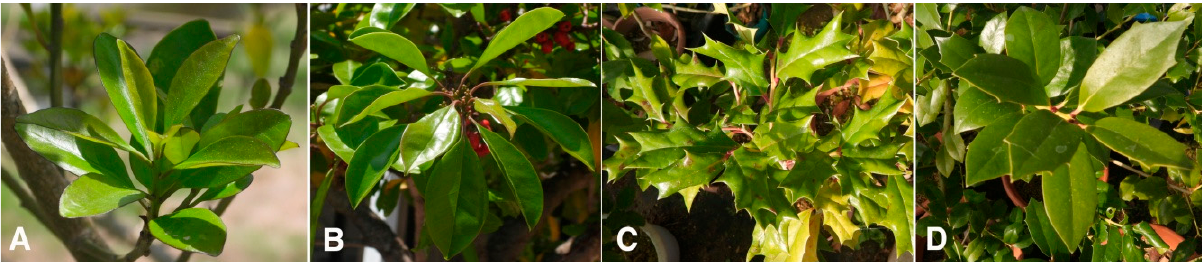
Figure 1. Typical leaf shape of I. integra ( A ), I. rotunda ( B ), I. cornuta ( C ), and I. x wandoensis ( D ). Plant DNA barcoding using markers based on ribosomal internal transcribed spacer (ITS) and chloroplast universal regions, including matK , rbcL , and trnH-psbA , is a common method for species identification and classification. However, it is difficult to accurately distinguish different species from a single plant genus using a few core DNA barcode regions; discriminating between closely related species or sub-species is particularly challenging [17,18]. Therefore, a complementary method is needed using a specialized DNA barcode region to distinguish closely related species or similar species from the same